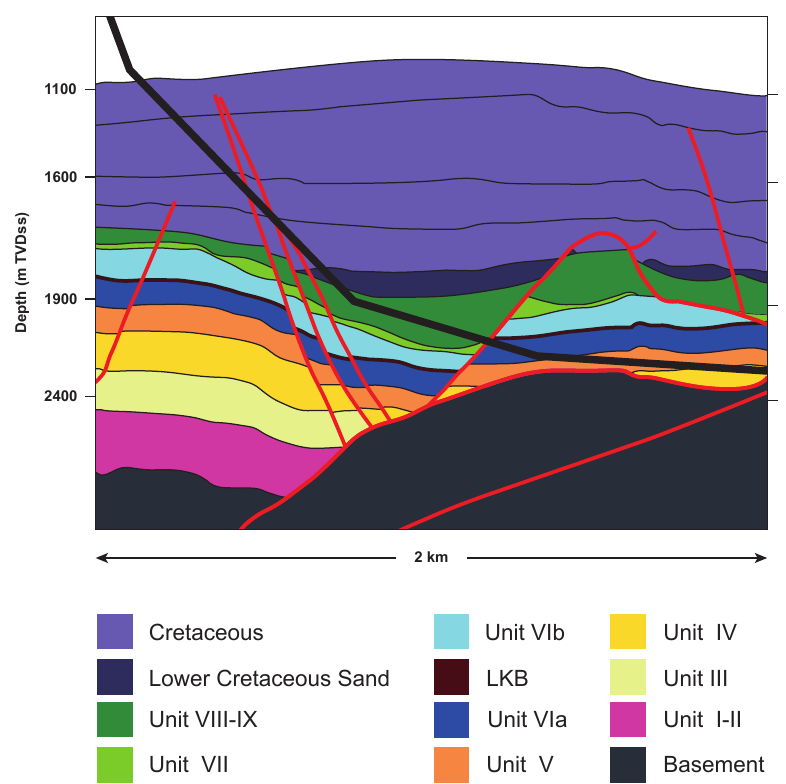
Figure 15. Interpreted schematic geological section along the path of well 206/8-A16 illustrating the geology encountered down to Unit IV, adapted from Morton and Milne [74]. Continued drilling led to penetration of Unit III before TD (see Figure